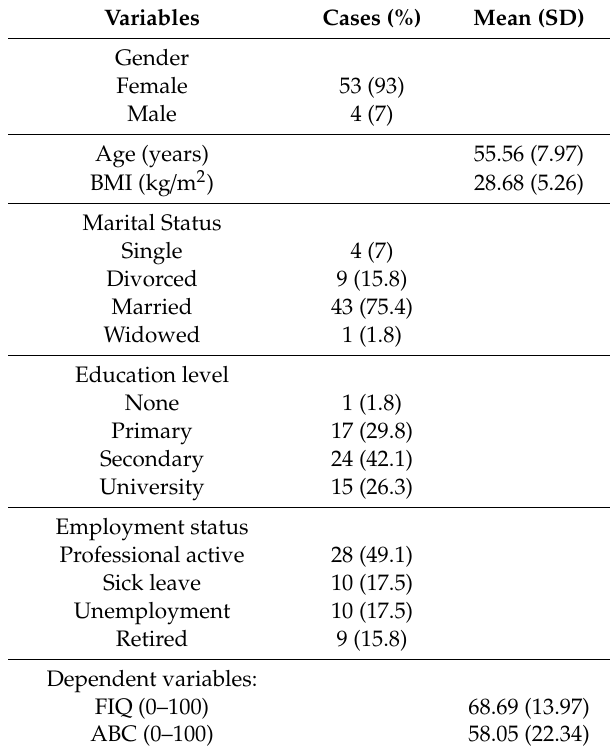
Table 1. Descriptive characteristics of patients with moderate-severe impact of fibromyalgia syndrome